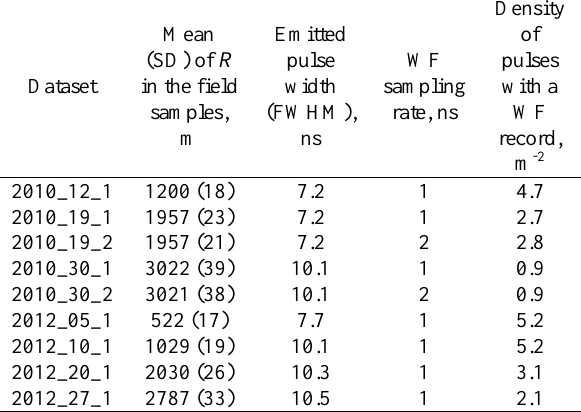
Table 1. Overview of the LiDAR